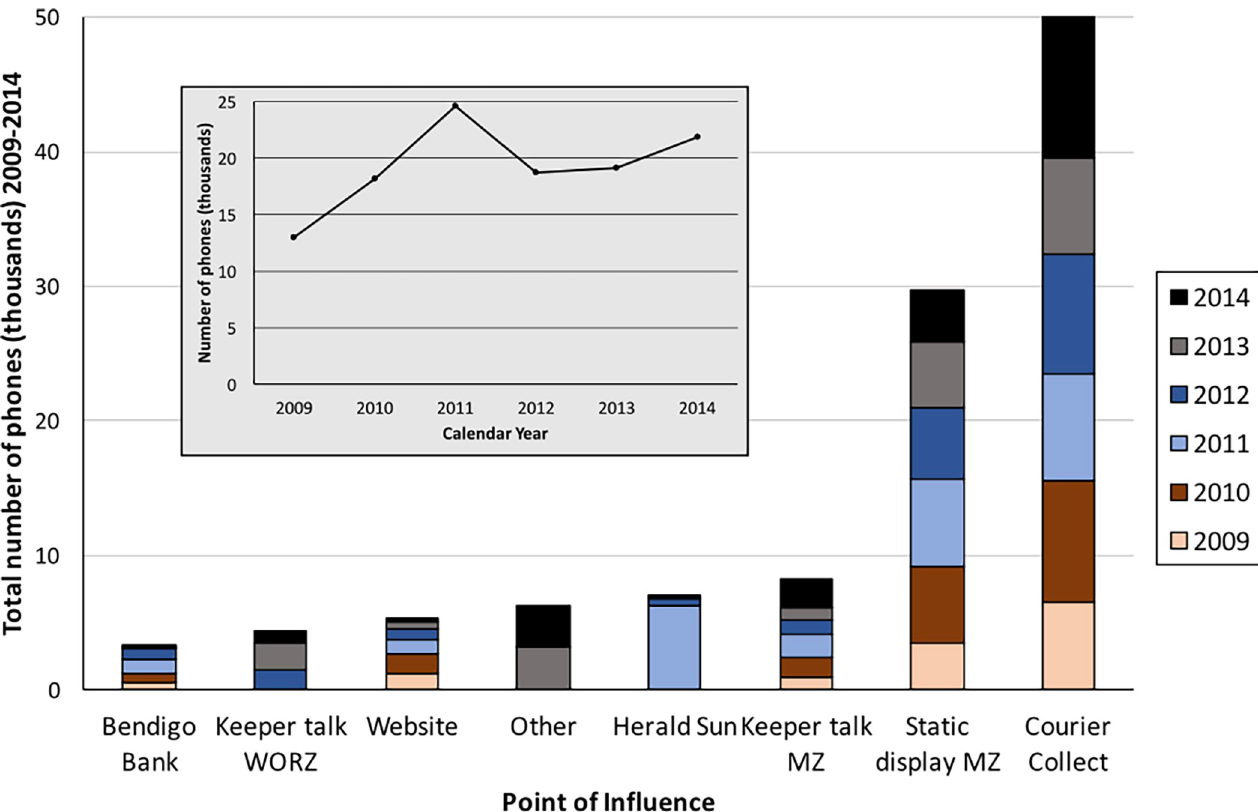
Fig 4. The total number of phones donated to each point-of-influence for the six-year period (2009–2014). The stacked column chart presents bar height as total number of phones for each POI and colored sections within each bar indicate the relative proportion of phones collected in each calendar year. POI is arranged from least (left) to most (right) phones collected. It should be noted that Melbourne Zoo Keeper Talks MZ, Static Display MZ, the Website, and Bendigo Bank POI were conducted throughout (from January 2014), the other POIs were conducted for only part of the 6-year period (as described in the procedure section). The grey inset shows total phones collected (y-axis) for each calendar year